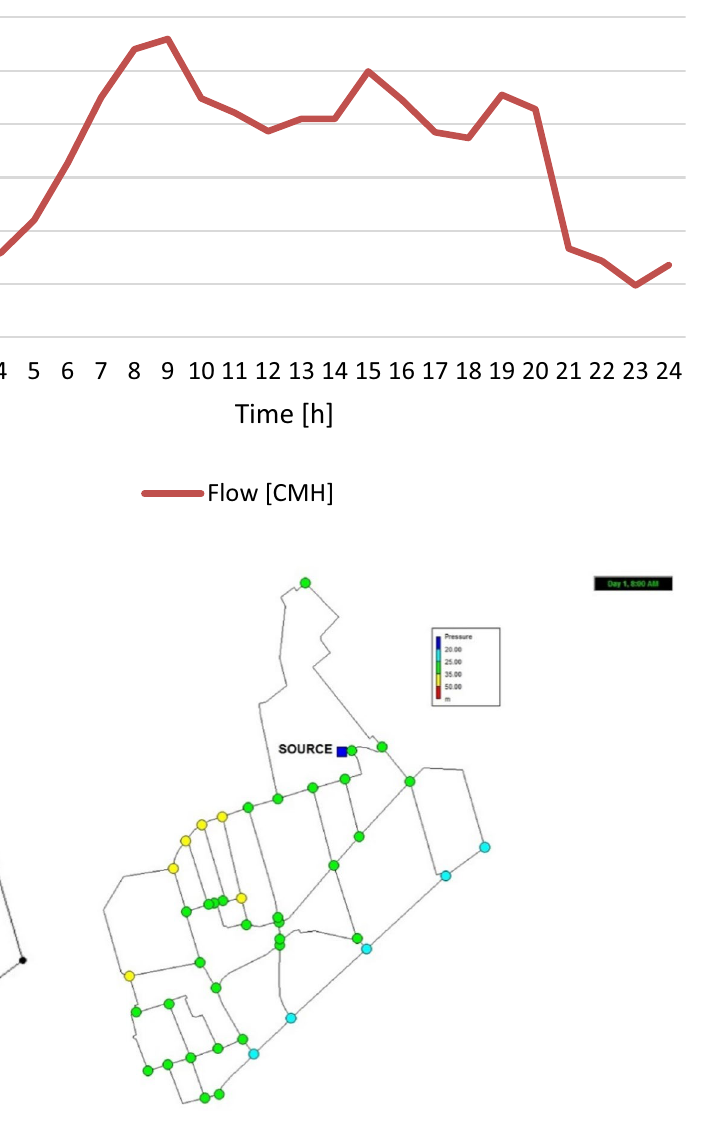
Fig. 6 Pressure distribution in nodes in the water supply network at the time of the highest